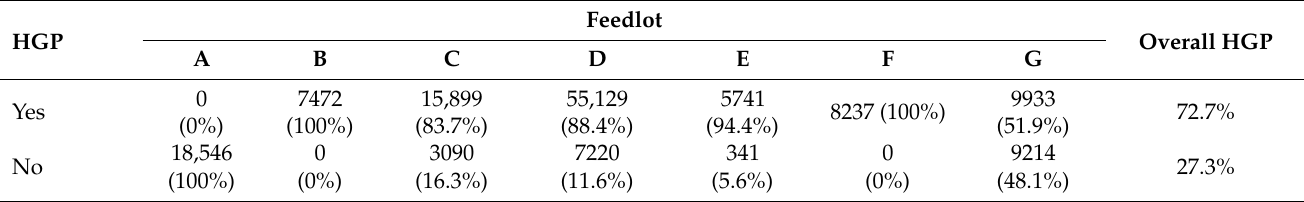
Table 5. Number of cattle implanted with hormone growth promotants (HGP; %) across the seven feedlots during the study.